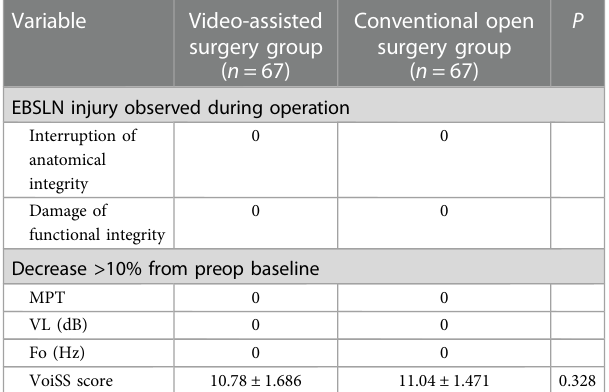
TABLE 1 Characteristics of the enrolled patients ( n =134).